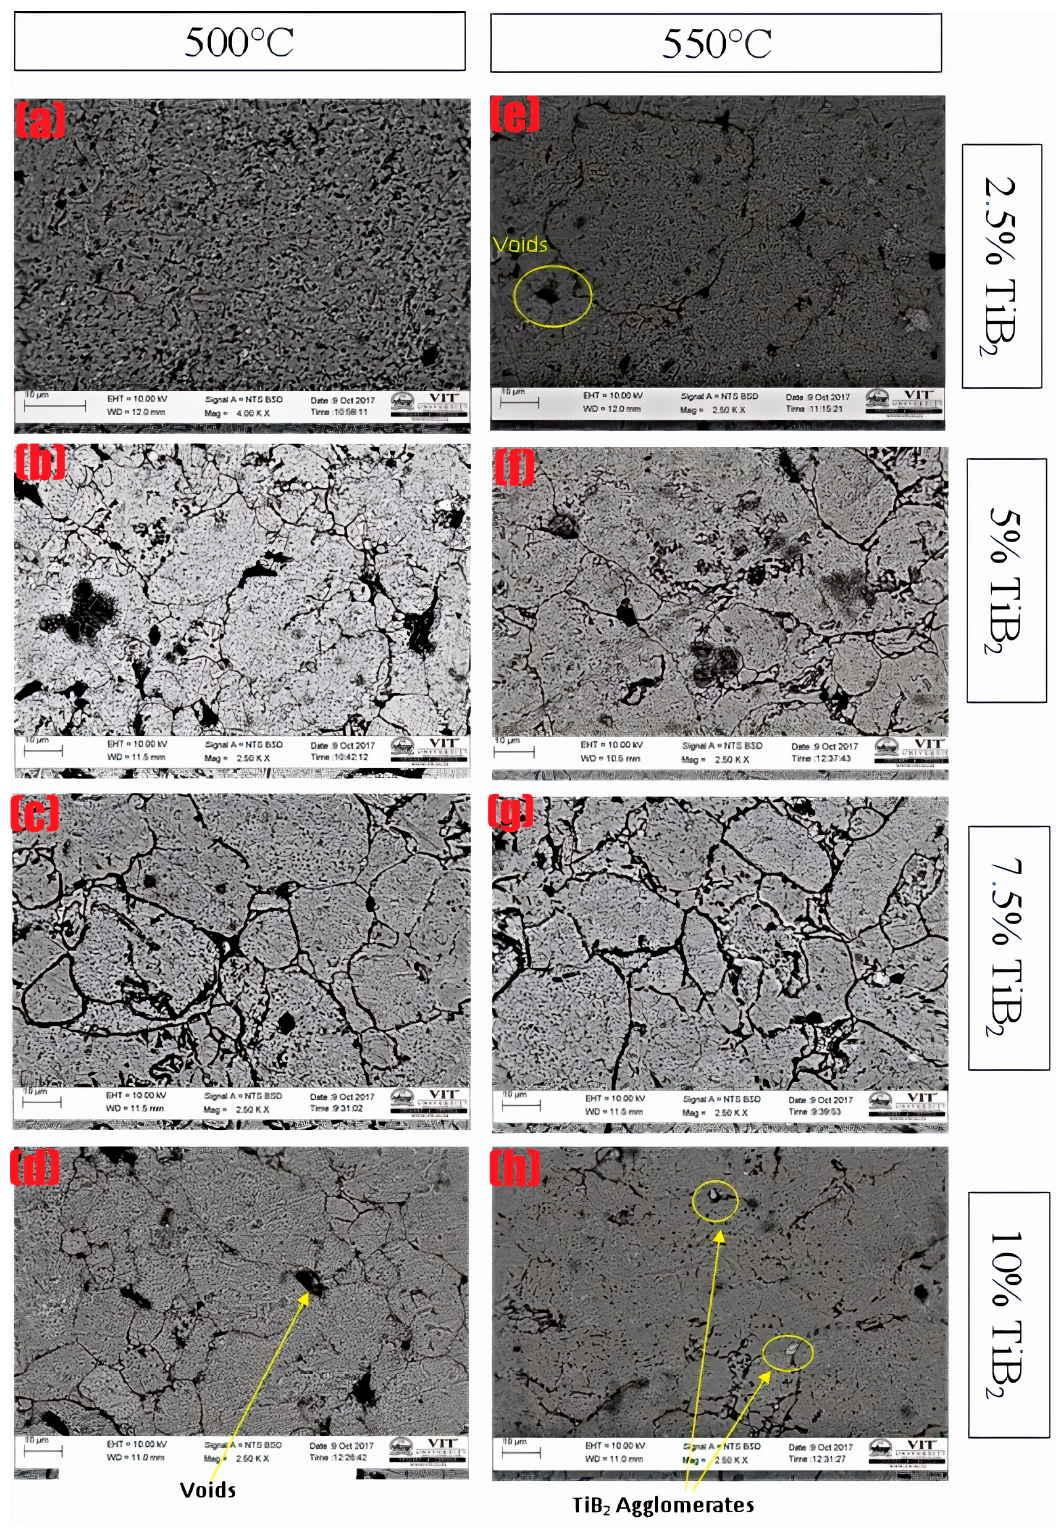
Figure 3. Scanning electron micrographs of spark plasma sintered Al-TiB 2 composites, 500 ◦ C. ( a ) 2.5% TiB 2 , ( b ) 5% TiB 2 , ( c ) 7.5% TiB 2 , ( d ) 10% TiB 2 ; 550 ◦ C: ( e ) 2.5% TiB 2 , ( f ) 5% TiB 2 , ( g ) 7.5% TiB 2 , ( h ) 10% TiB 2 .